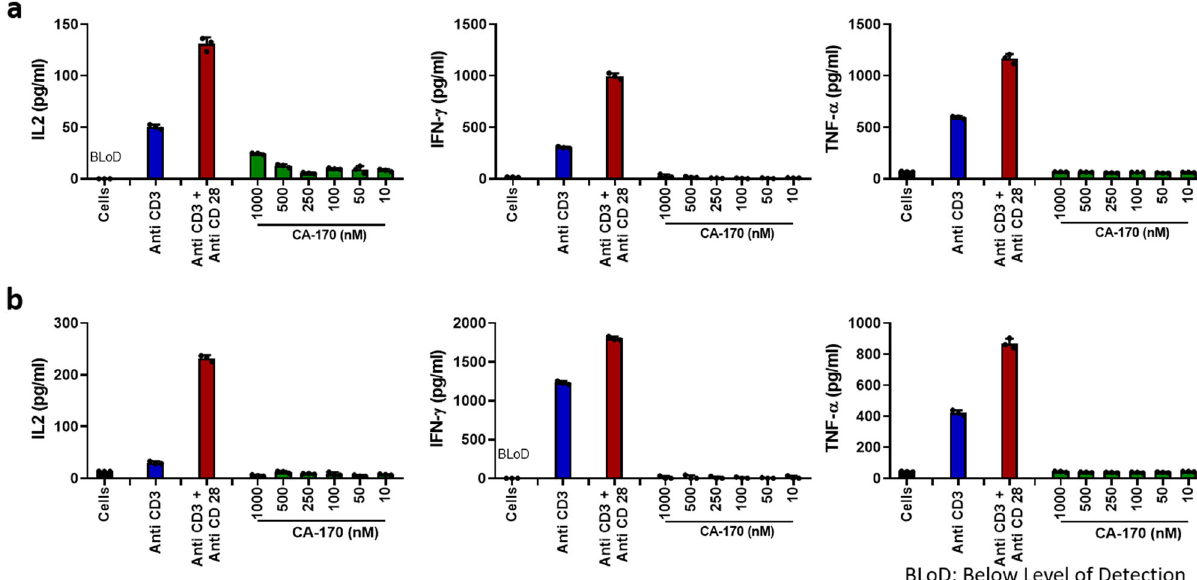
Fig. 2 In vitro cytokine induction assay. a Human PBMCs from healthy donors were pre-cultured at high density (1 × 10 7 cells/ml) for 48 h to increase cell – cell contacts and immune scanning. The cells were then harvested and treated with anti-CD3 or anti-CD3 + anti-CD28 antibodies as positive controls, and CA-170 (10 nM to 1000 nM). Release of IL-2, IFN- γ , and TNF- α was measured in the culture supernatants at 48 h. Two donors were used in this study (one male and one female); there was no gender difference observed in the cytokine response in this study. Data presented is representative data from a male donor (BLoD Below Limit of Detection). b Cytokine levels determined in PBMCs from the same donor with similar experimental conditions but cultured at a normal density of 1 × 10 5 cells/well for 48 h for comparison. For a – b each bar in the fi gure denotes mean ± SD from the three